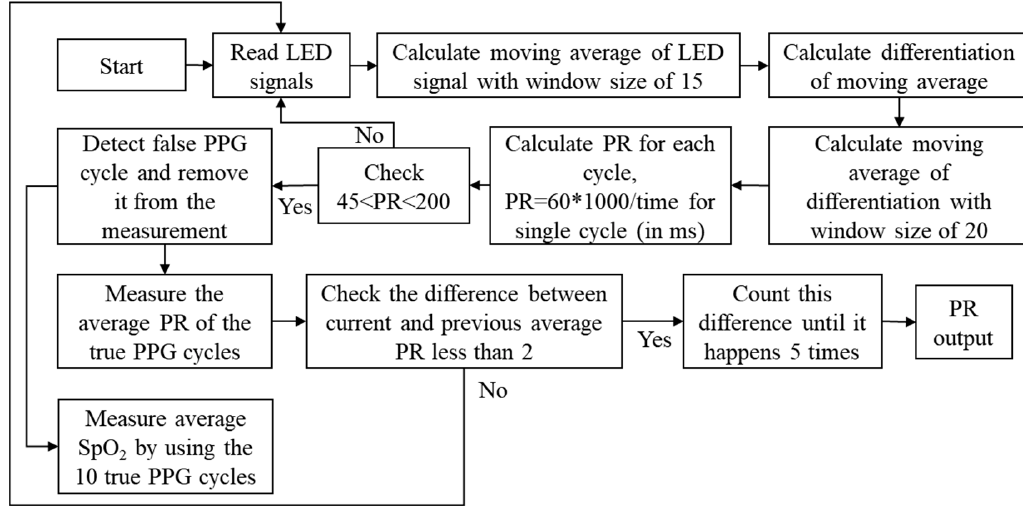
Figure 9. Block diagram for estimating pulse rate (PR) and SpO 2 .